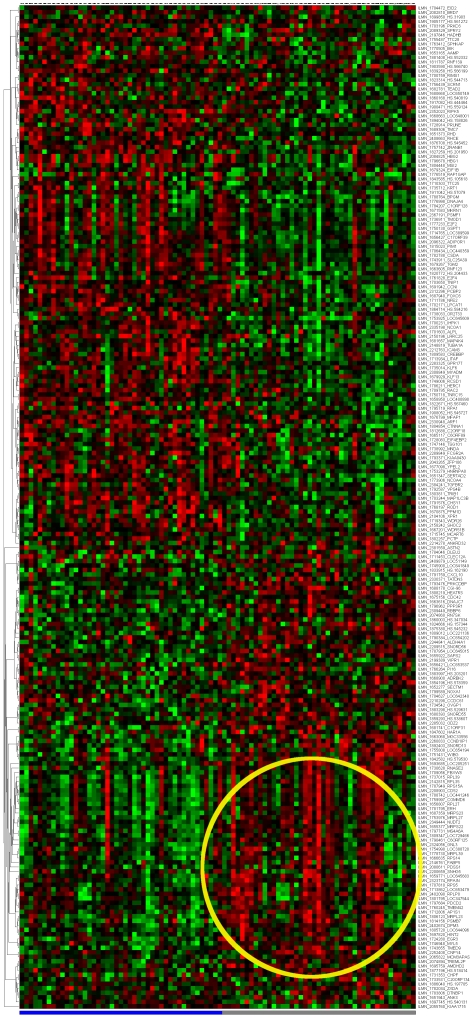
mRNA expression heatmap for the C/PP signature.Control samples (blue), PPMS (grey). Note the pattern of ‘bars’ near the bottom right of the heatmap (circled) where expression broadly alternates between up- (red) and down- (green) regulated in disease. This regular pattern could indicate that PPMS contains distinct subgroups with respect to gene expression.